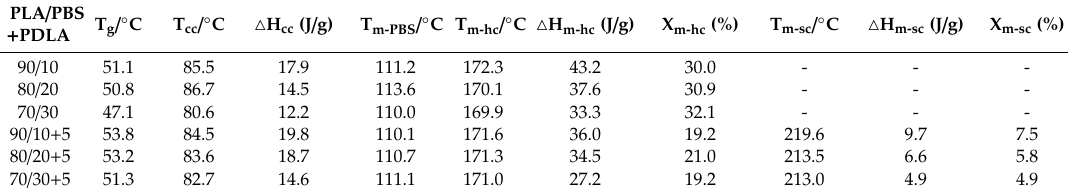
Figure 2. DSC curves of PLA / PBS blends with or without PDLA ( a ) the first heating curves ( b ) the first cooling curve ( c ) the second heating curves. Table 2. Di ff erential scanning calorimetry (DSC) parameters for crystallization of poly ( l -lactide) (PLLA) / PBS and PLLA / PBS / PDLA in the first heating